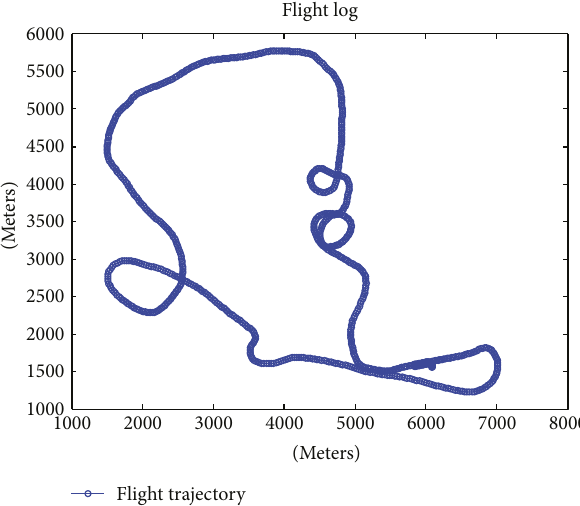
Figure 8: Flight test log of manned helicopter. Figure 7: Flight test log of